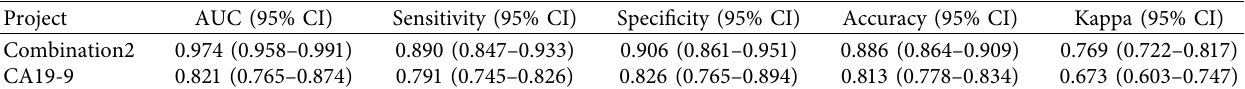
Table 5: The abilities of combination2 and CA19-9 in PC